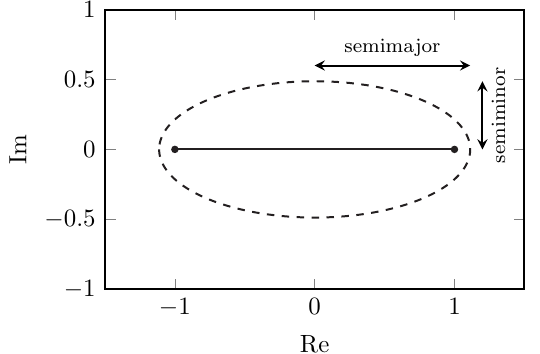
Figure 1. The E 1.6 Bernstein ellipse. Its size ρ is equal to the sum of its semiminor and semimajor axes—in this case, 1.6. Its foci 1 and 1 are shown by the black −